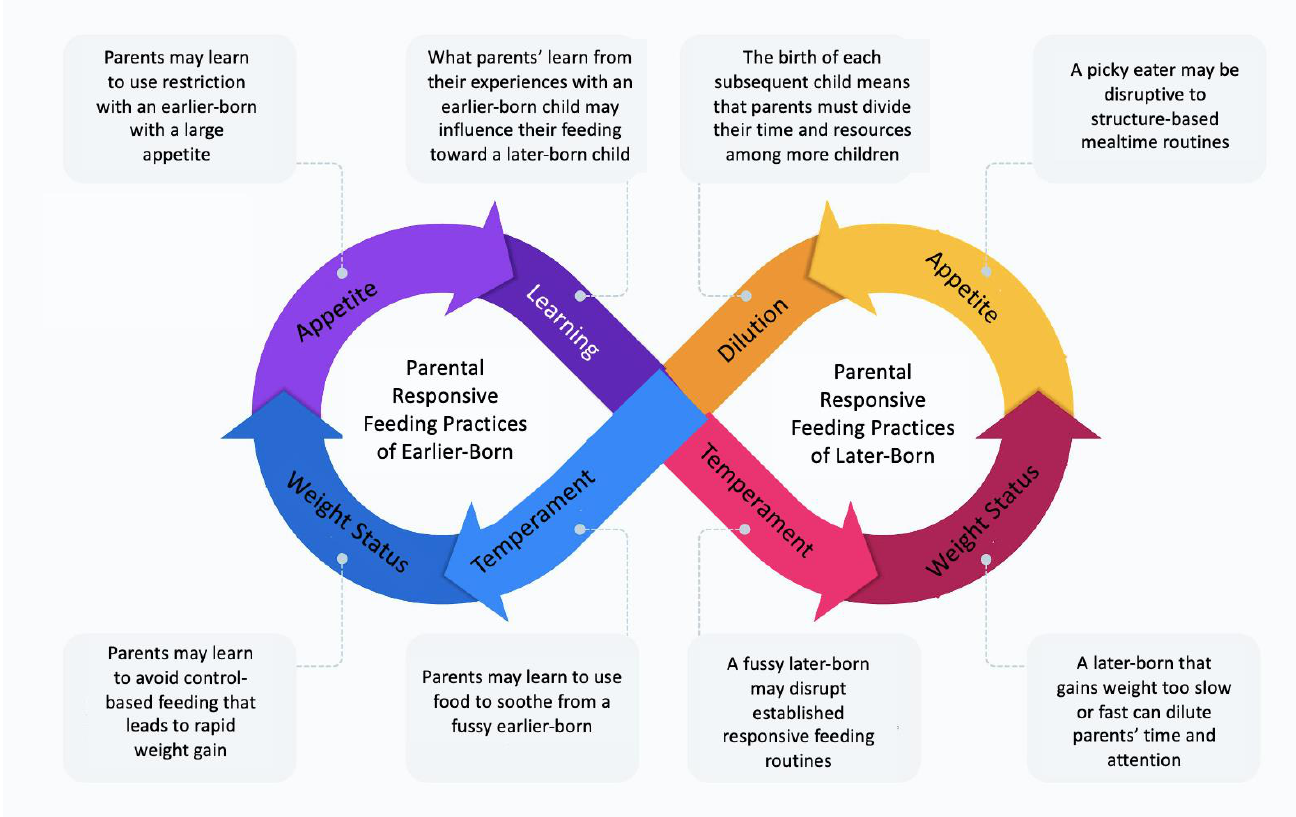
Figure 1. Conceptual model: The role of sibling-related family systems processes-learned experience and resource dilution—in parental responsive feeding.